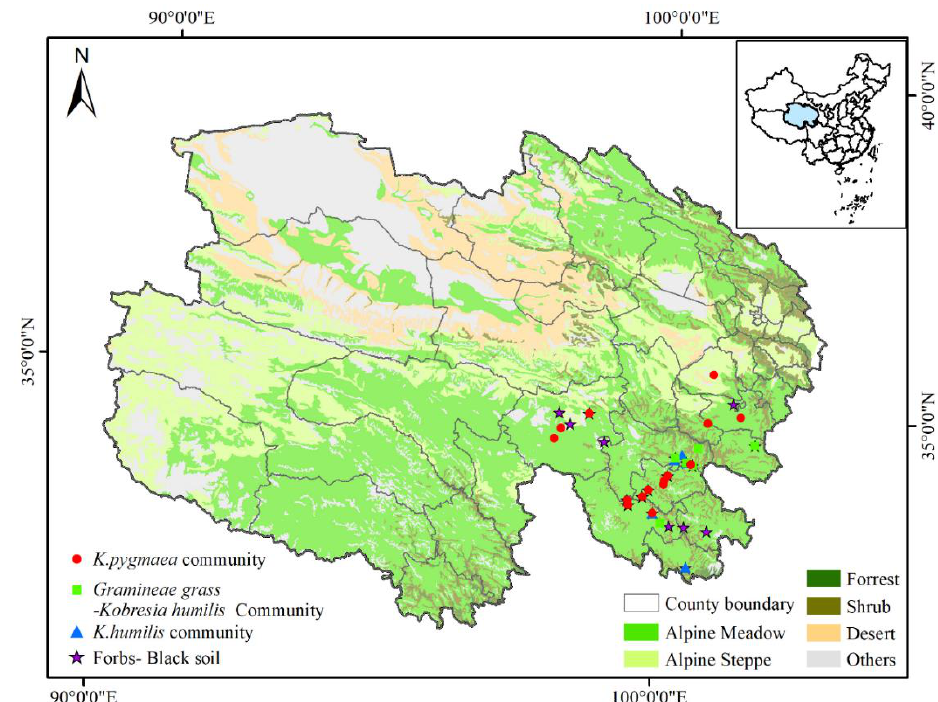
Figure 1. Locations of research sites in the multi-stable alpine meadows in southeastern Qinghai Province.